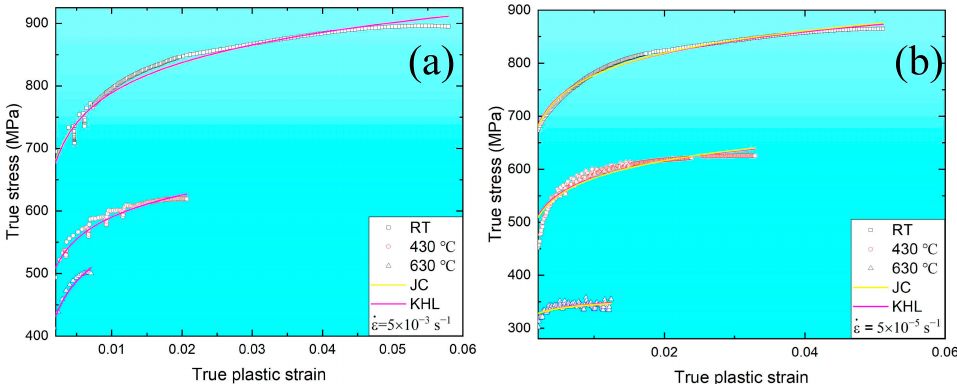
Figure 16. The predicted true stress–true plastic strain curves based on the JC and KHL models and experimental results at the strain rates of ( a ) 5 × 10 − 3 s − 1 and ( b ) 5 × 10 − 5 s − 1 .